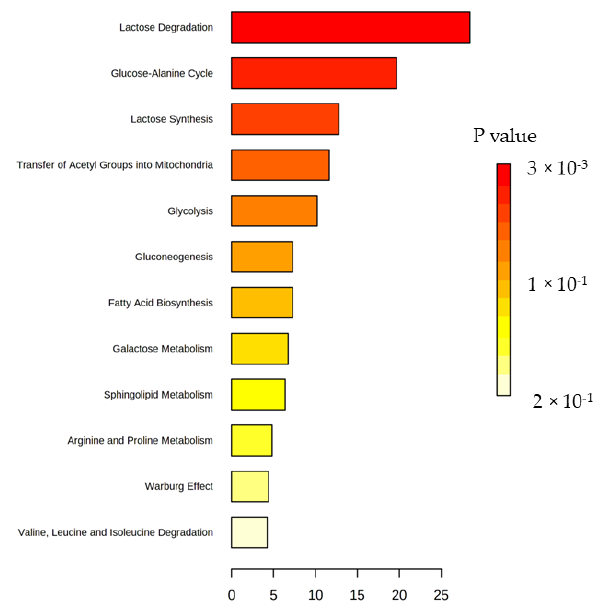
Figure A2. List of diseases identified by the Metabolite Set Enrichment Analysis (MSEA) using the metabolites found to discriminate between patients and controls.